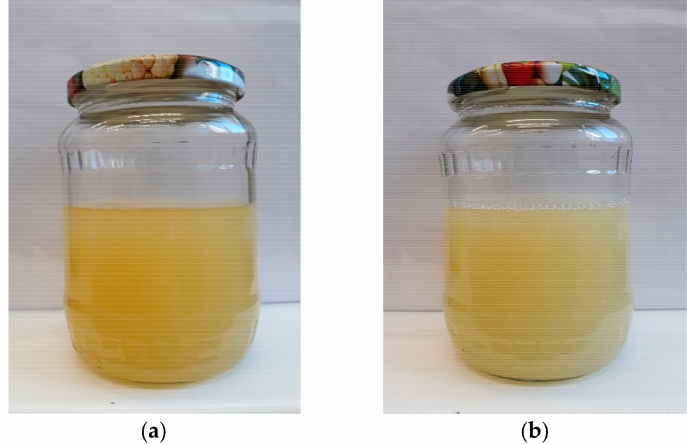
Figure 2. Test fuel blends after application of stirring: ( a ) M10, ( b )